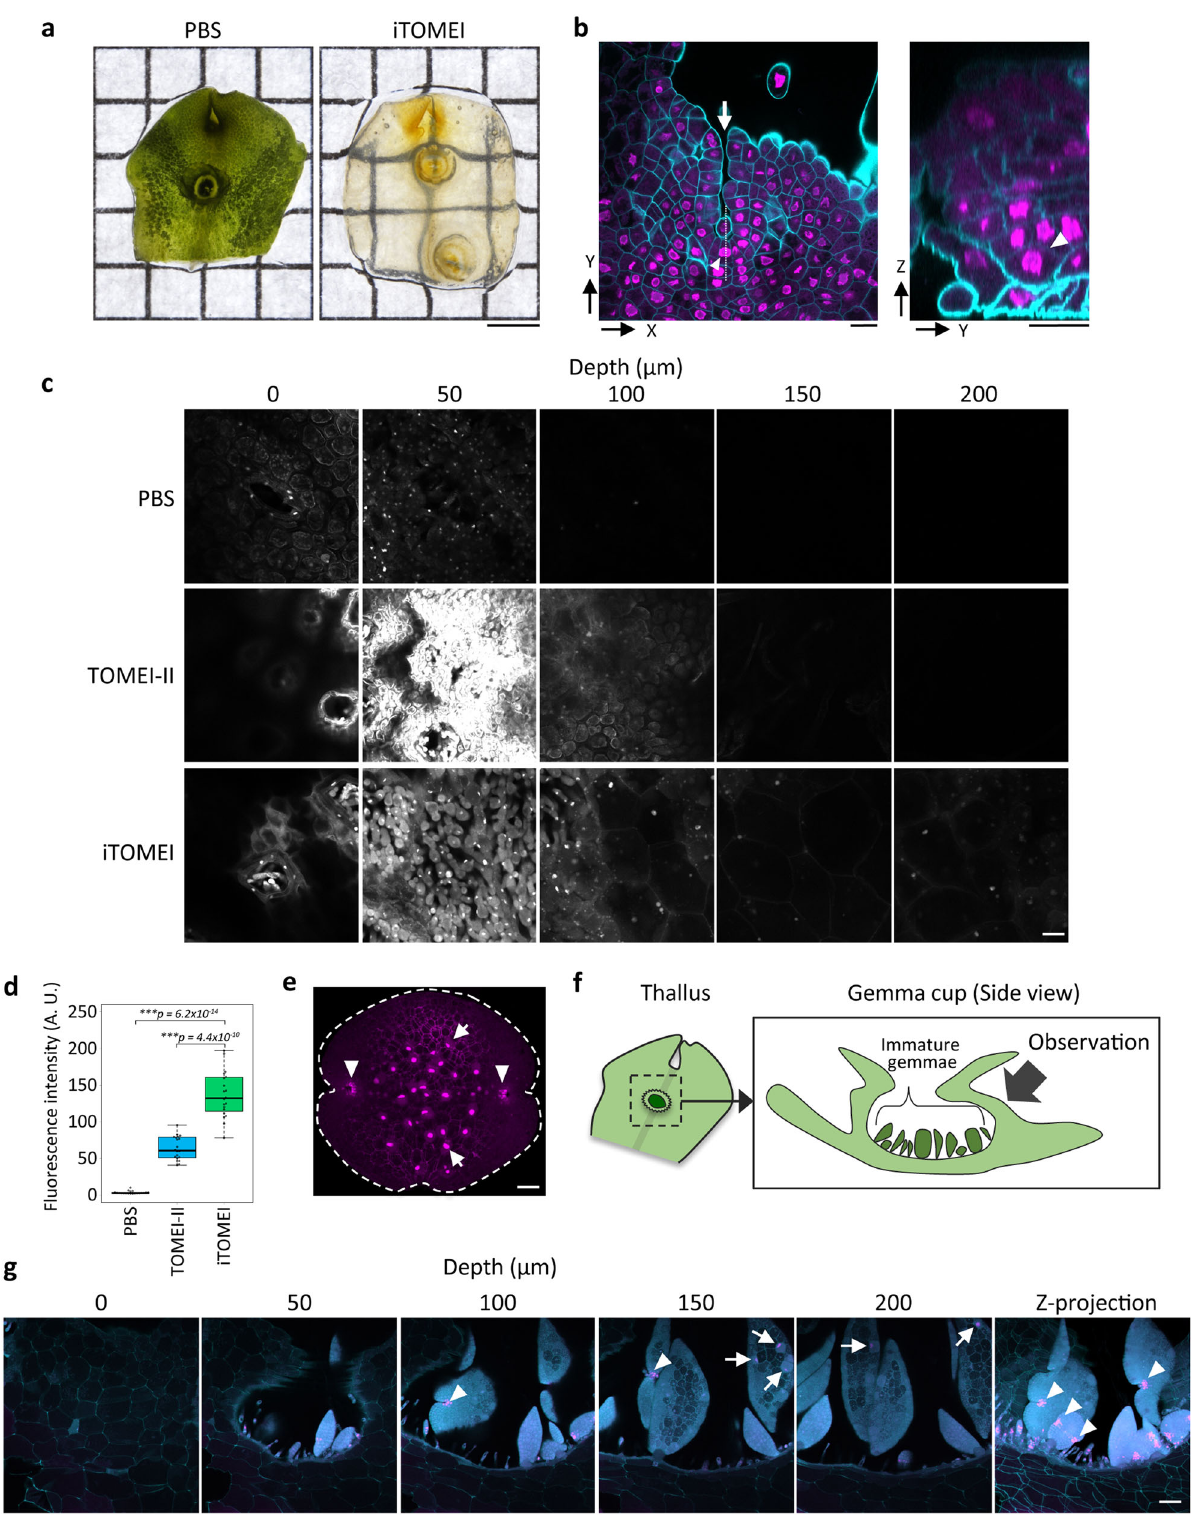
buffer, SeeDB2, and iTOMEI-B. Although a 24-h treatment with iTOMEI-B was insuf fi cient to clear the brain, a 48-h treatment achieved high transparency (Supplementary Fig. 5a). iTOMEI-B inhibited the change in slice size to the same degree as SeeDB2 (Supplementary Fig. 5a). Hemi brains expressing EGFP were also treated with PBS buffer, SeeDB2, and iTOMEI-B and observed from the brain ’ s cortical surface using a two-photon excitation